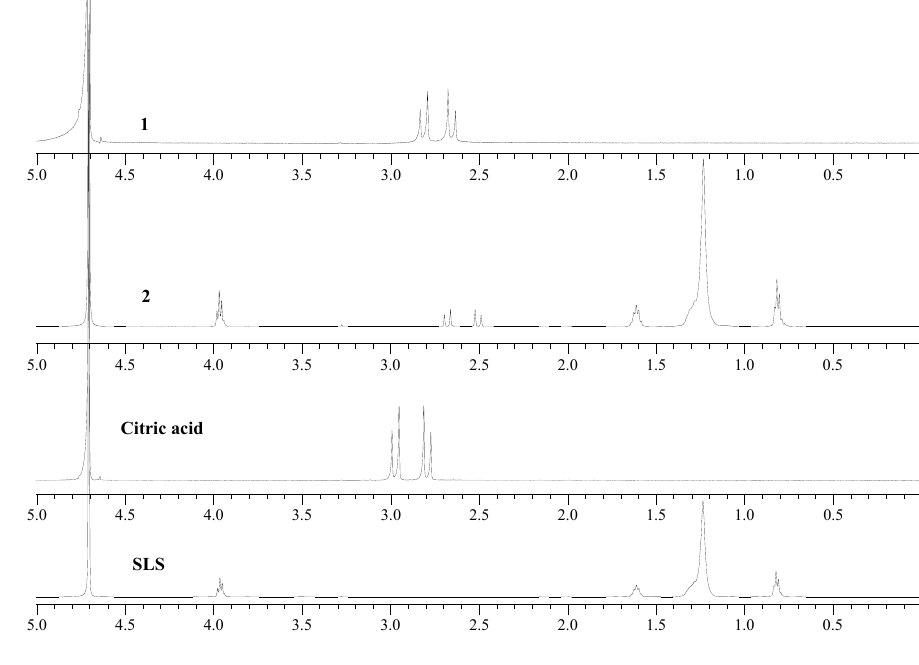
Figure 2. Spectra of 1 – 2 and SLS and CitH 4 in D 2 O.